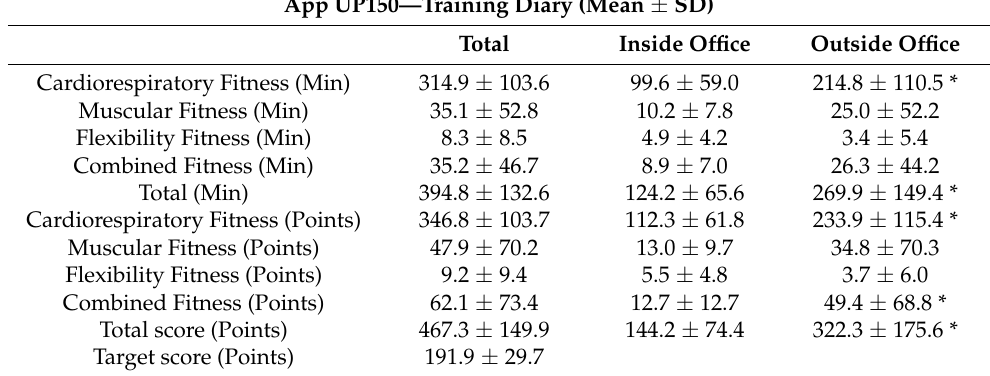
Table 6. App UP150—Training diary mean